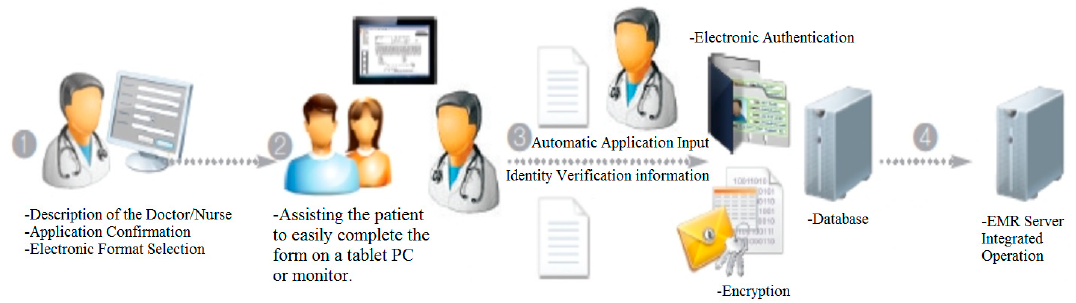
Figure 1. The workflow of the electronic solution provided for medical checkups or surgeries.